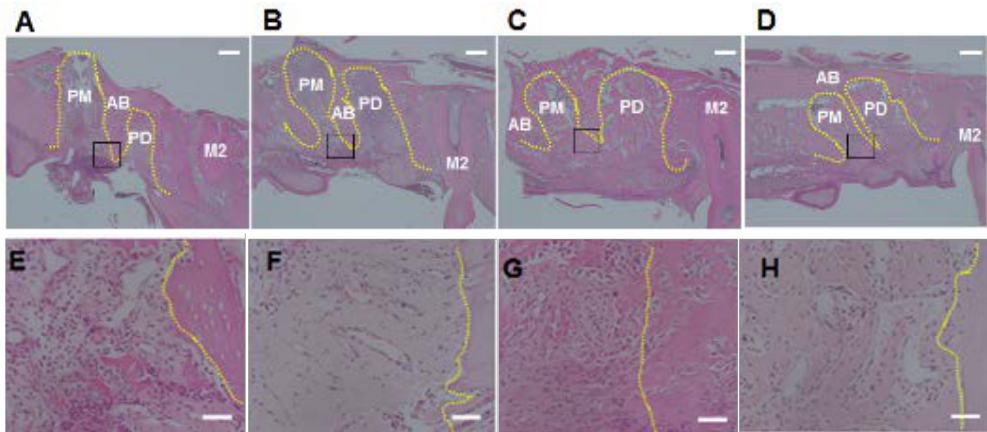
Figure 3. Photographs of alveolar sockets stained with hematoxylin and eosin at 3 days ( A and E : control group; B and F : experimental group) and 8 days ( C and G : control group; D and H : experimental group) (Scale bar = 400 μm ( A – D ) and 50 μm ( E – H )). The number of polymorphonuclear leukocytes was low in the experimental group compared with the control group at 3 days. On the other hands, both the groups showed low number of polymorphonuclear leukocytes at 8 days. Yellow dotted line: outline of alveolar socket. Black square: areas of E – H ; AB: alveolar bone; PM: alveolar socket at palatal mesial root of maxillary first molar; PD: alveolar socket at palatal distal root of maxillary first molar; M2: maxillary second molar.